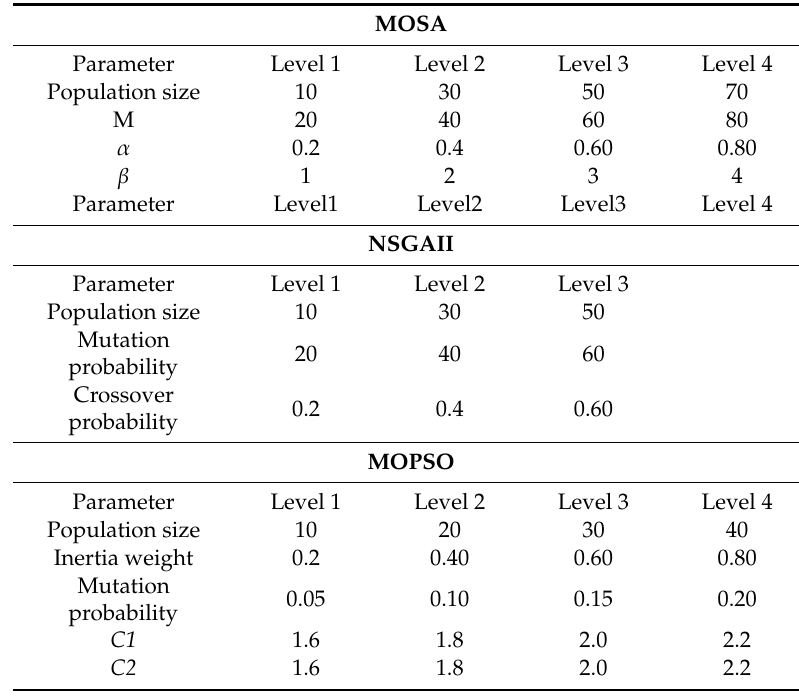
Table 3. Level and e ff ective parameters for MOSA, NSGAII, and MOPSO ( Multi objective particle swarm